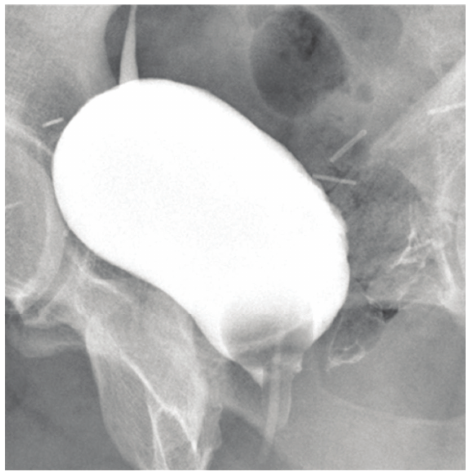
Figure 3: Retrograde cysto-uretrography after conservative treat- ment. Oblique radiograms of bladder after full repletion with contrast media, acquired 70 days later, depict the closure of the fistolous